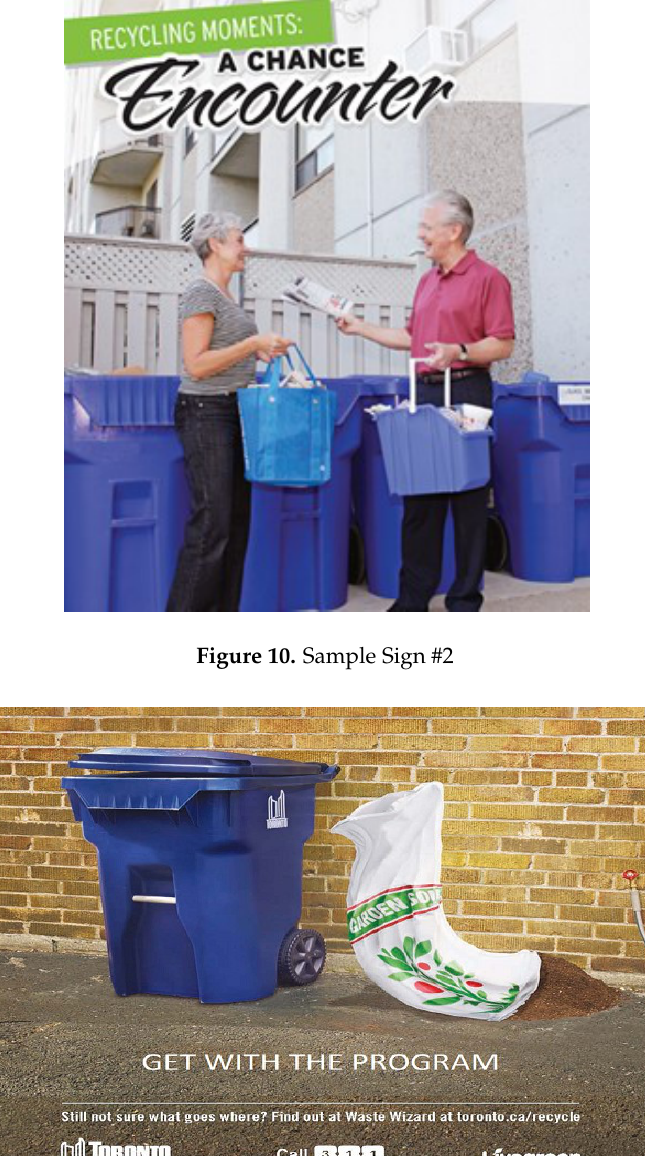
Figure 11. Sample Sign #3.